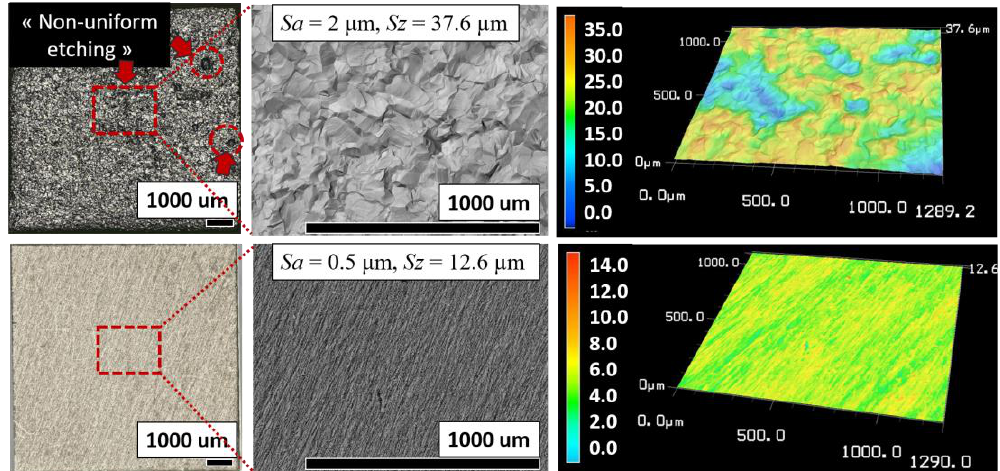
Figure 4. Optical and 3D images were acquired by a laser confocal microscope (Keyence VKX200) for BCP-treated samples ( left ) and “as received” samples ( right ). Note: red arrows show variations in surface etching patterns due to hidden structures in the bulk Nb.